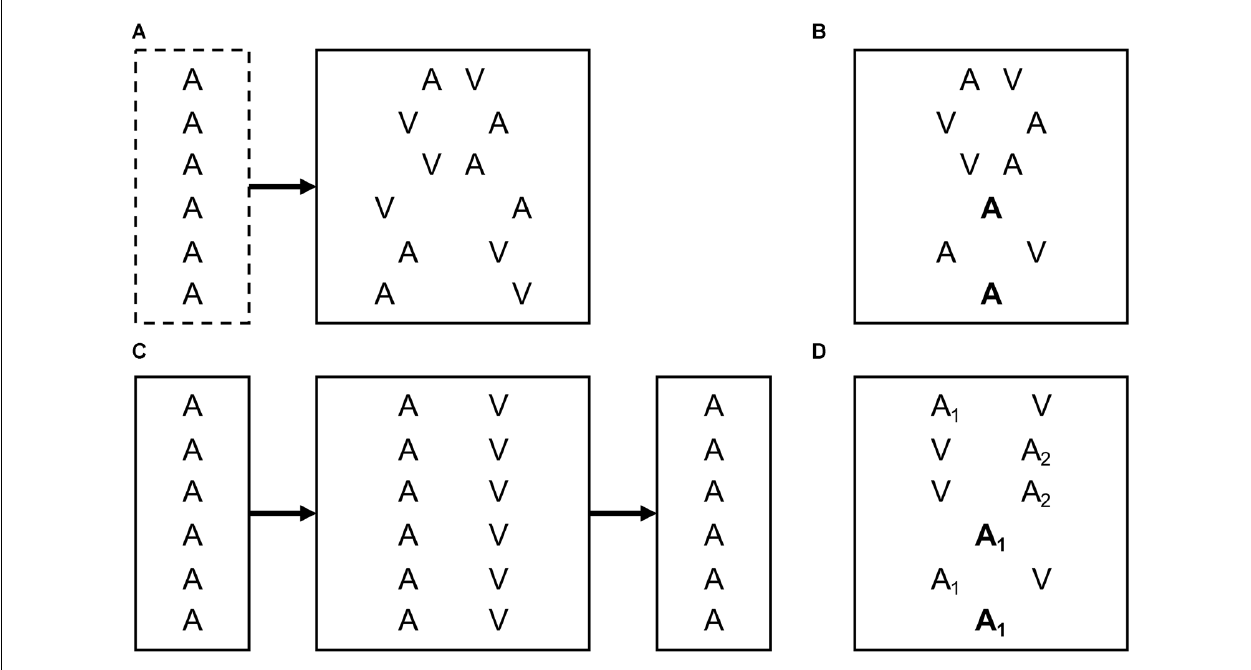
FIGURE 1 | Typical experimental designs to measure the ventriloquism effect and aftereffect. Exemplarily, letters indicate unimodal auditory (A) trials and relative locations of auditory (A) and visual (V) stimuli in bimodal trials. In an actual experiment, absolute stimulus locations typically vary between trials. (A) Ventriloquism effect. Participants have to localize cross-modal stimuli with varying spatial discrepancies. Unisensory localization is assessed in an optional pretest block. Comparison of responses between equivalent left- and right-side discrepancies or between bimodal and unimodal stimuli reveal the size of the ventriloquism effect. (B) Immediate ventriloquism aftereffect. Intermixed presentation of bimodal and unimodal trials. Localization in unimodal trials is modulated by the cross-modal discrepancy in the directly preceding bimodal trial. (C) Cumulative ventriloquism aftereffect. Unisensory sound localization is measured before and after exposure to cross-modal stimuli with a consistent spatial discrepancy. (D) Design used in Bruns and Röder (2015) to measure the immediate and cumulative ventriloquism aftereffects concurrently. Tones of two different sound-frequencies (A 1 and A 2 ) are consistently paired with opposite directions of cross-modal spatial discrepancy. Differences in localization responses between unimodal trials preceded by audiovisual trials with leftward vs. rightward discrepancy reveal the immediate aftereffect, and differences between unisensory localization of A 1 vs. A 2 reveal the cumulative aftereffect (see text for